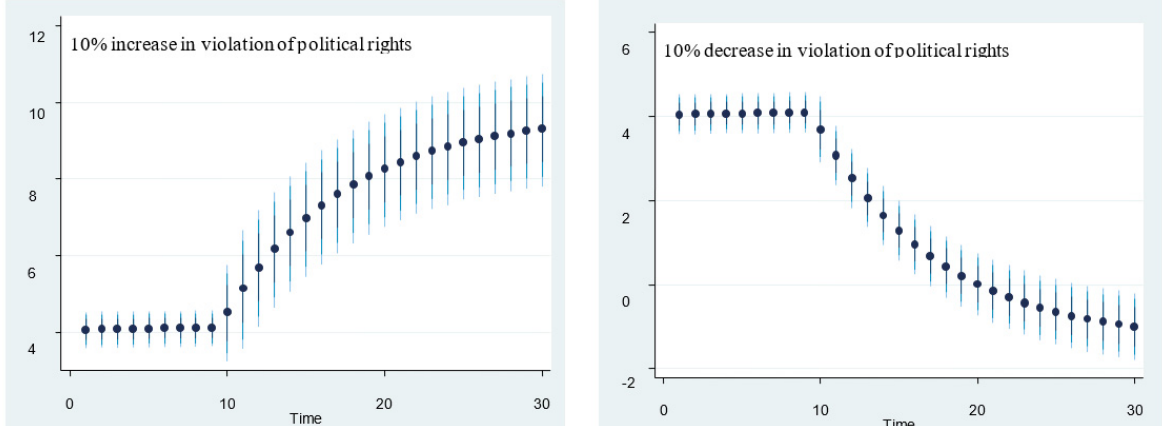
Figure 7. Violation of political rights and domestic investment. The above graphs portray ±10% in the violation of political rights and its impact on domestic investment. The dots depict the average prediction value, while the dark blue to light blue lines show 75%, 90%, and 95% confidence interval, respectively.